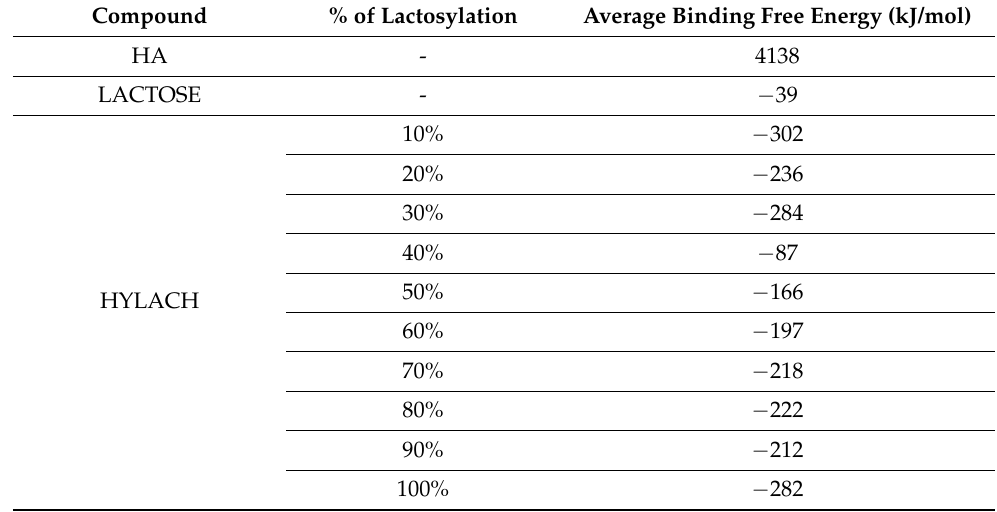
Table 2. Average binding free energies of the ligands.